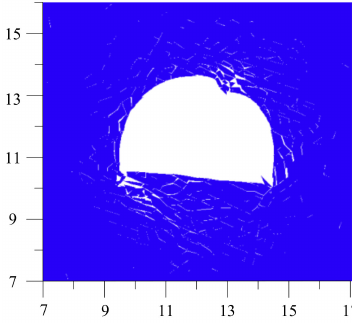
Figure 14. Simulated final deformation failure pattern of the roadway due to excavation